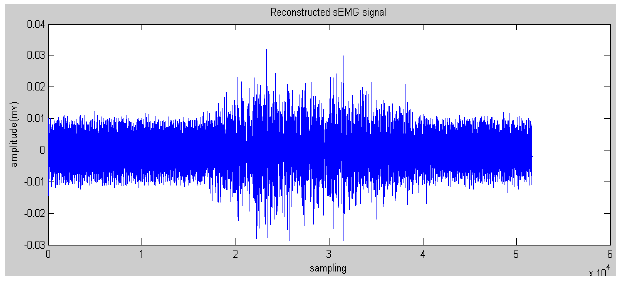
Figure 6. Reconstructed sEMG signals processed by WPT in node 4.1.